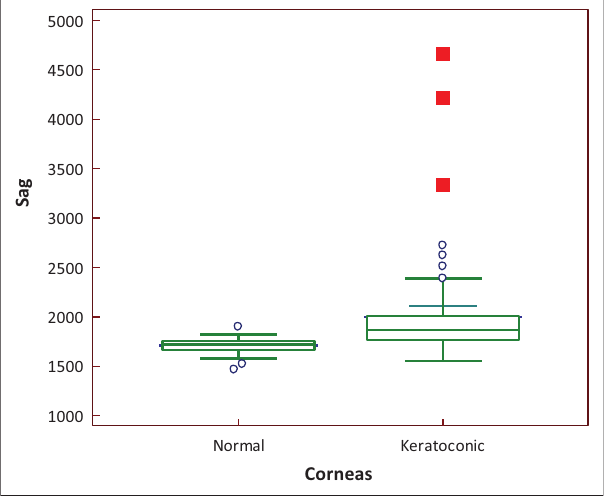
FIGURE 3: Box and whisker plots of sags for 50 normal and 75 keratoconic corneas are indicated. The mean is indicated by the line through each box that represents the 95 % CI on the mean (vertical dimensions). The whiskers show the minimum and maximum values, excluding outlying and extreme outliers (indicated by circles and squares,